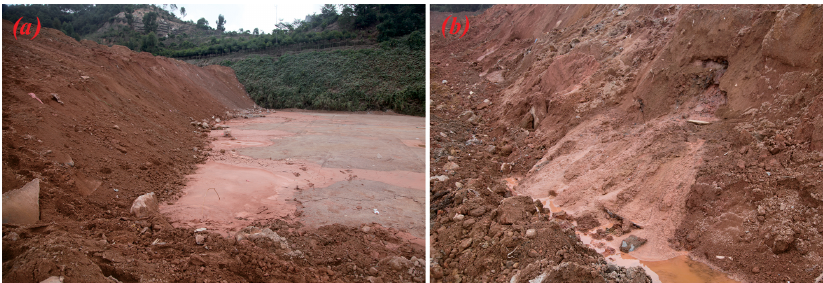
Figure 16. Evidence of liquefaction near the opening of the failed slope.